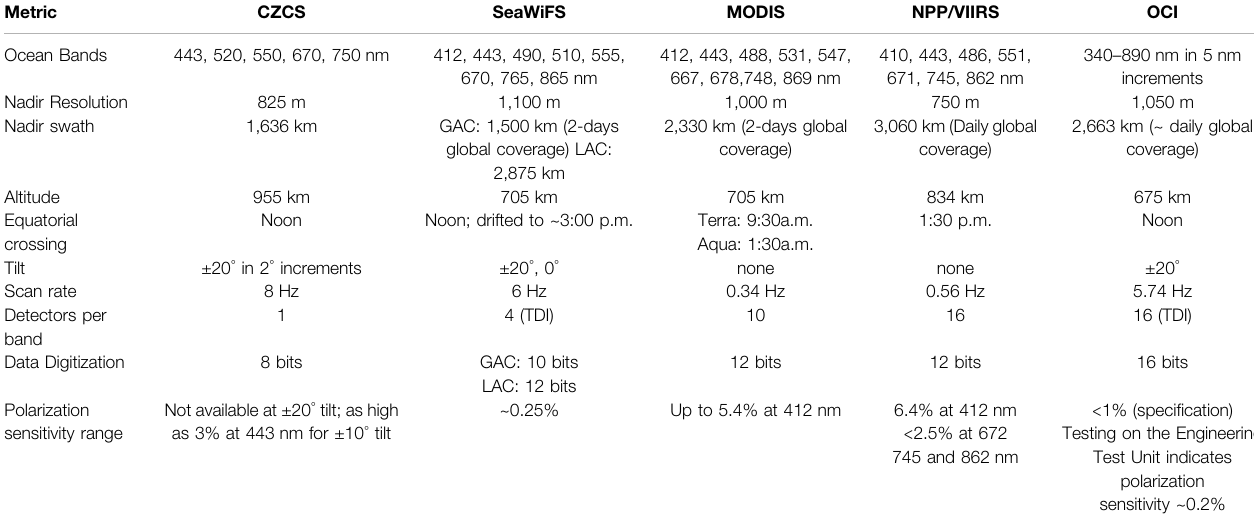
TABLE 1 | NASA satellite ocean color missions and sensor metrics. Metric